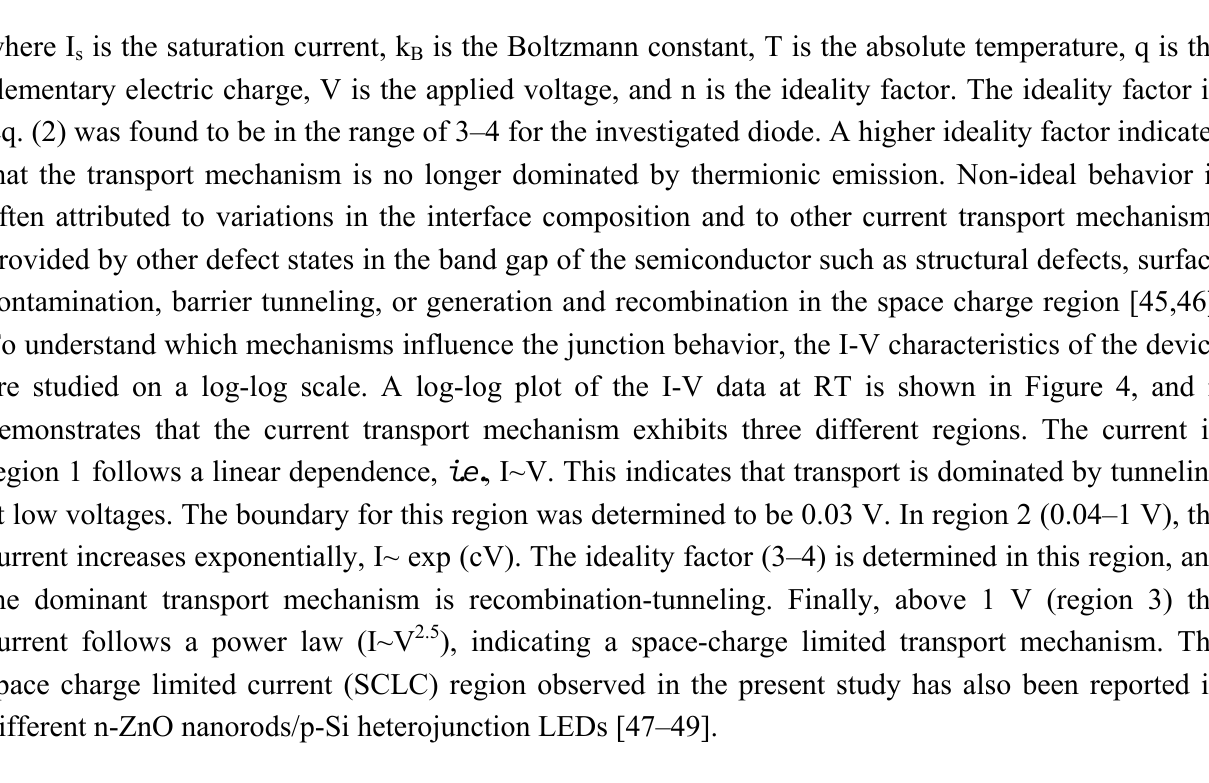
Figure 4. Log-log plot of the I-V characteristics of the 4H-p-SiC/n-ZnO heterojunction